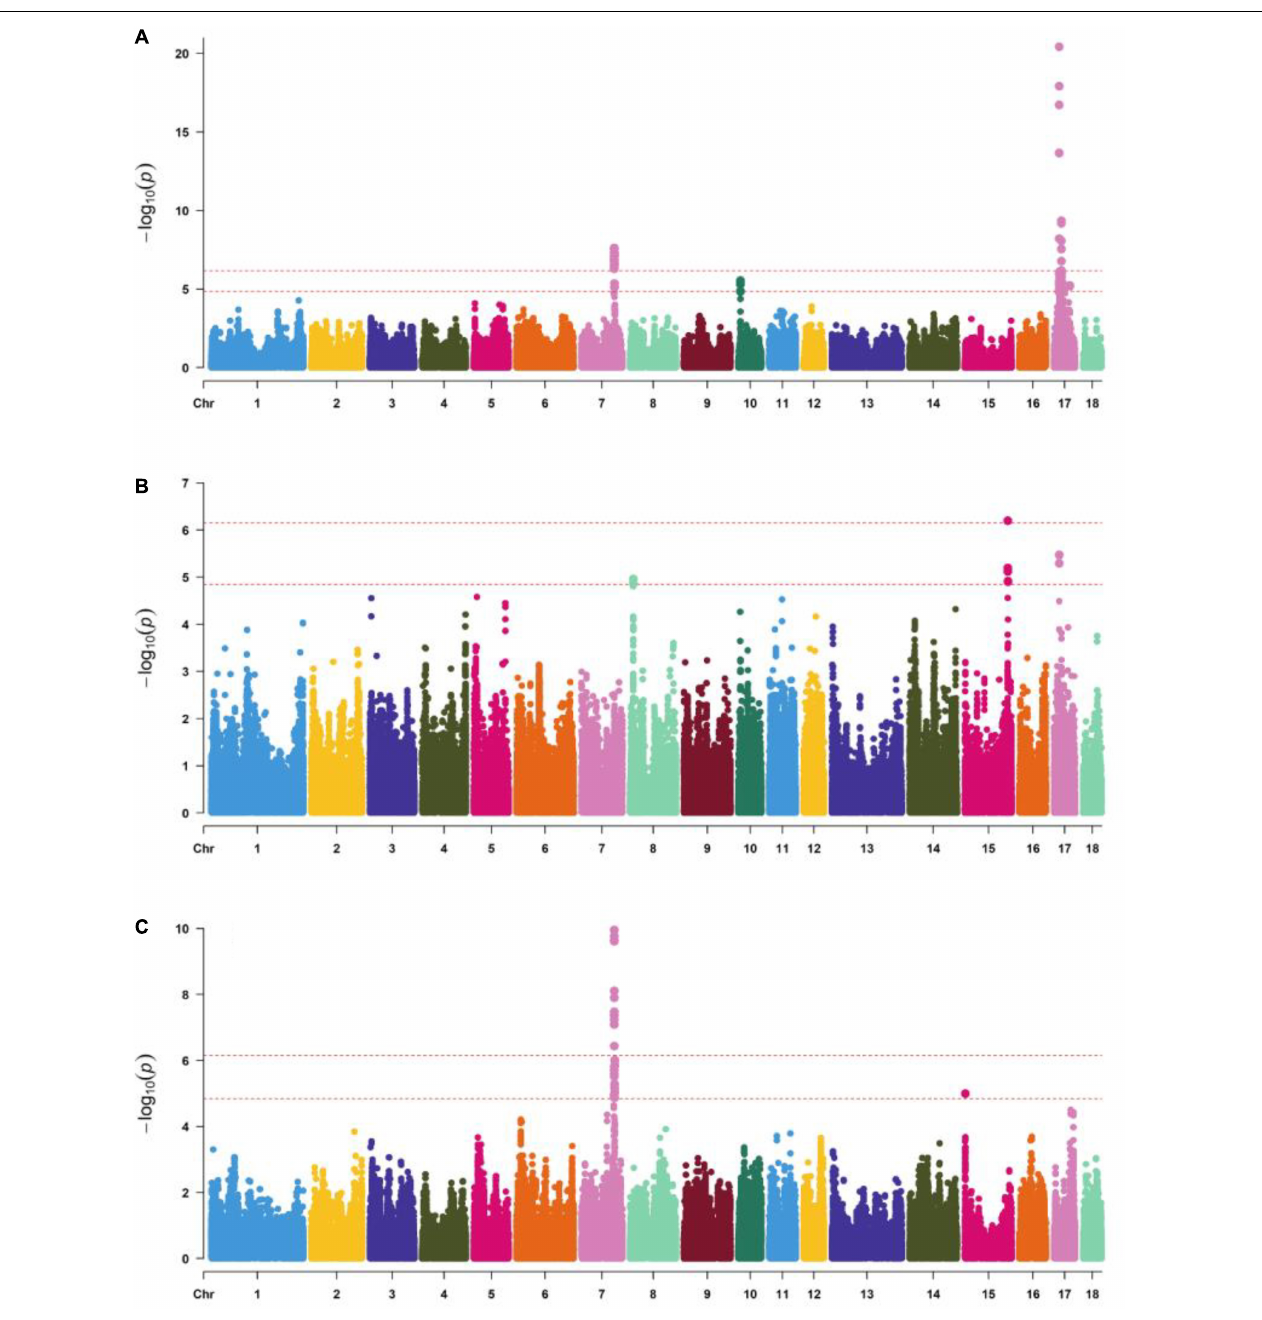
FIGURE 1 | Manhattan plots of genome-wide SNP significance for (A) body length, (B) body height, and (C) total number teats. The X axis shows SNPs across chromosomes SSC1 to SSC18, and the Y axis represents the –log10(P). The top line indicates the genome-wide significant thresholds ( P < 7.03E-7) and the bottom line indicates the suggestive genome-wide significant thresholds ( P <